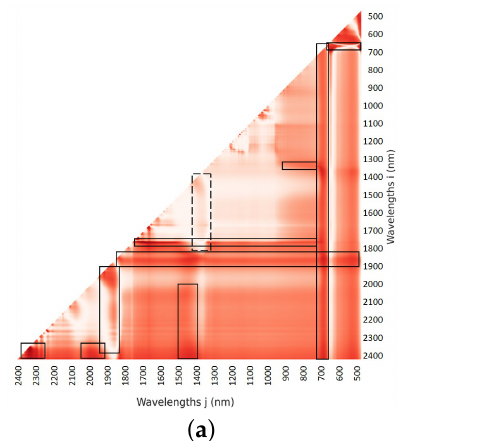
Figure 21. Scatterplots showing the relationship obtained between NDSI by wavelengths and SWP values for three examples. ( a ) NDSI with 1810 nm in “SWIR h” and 1650 nm in “SWIR g”; ( b ) NDSI with 1910 nm in “SWIR j” and 1650 nm in “SWIR g”; ( c ) NDSI with 1910 nm in “SWIR j” and 2200 nm in “SWIR l”.